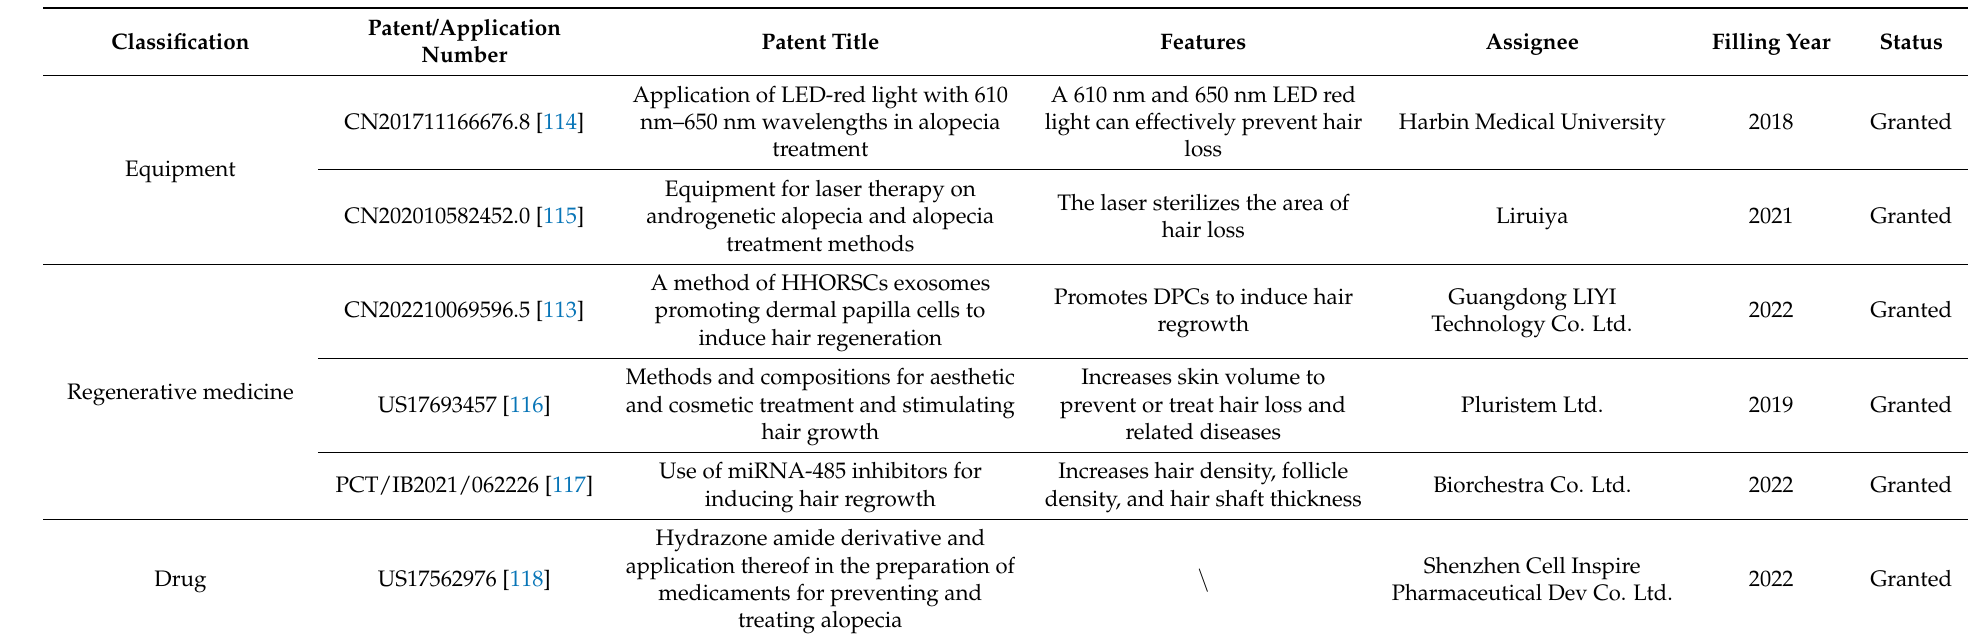
Table 5. Recent patents for hair regrowth